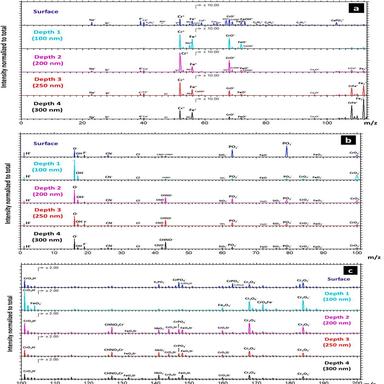
ToF-SIMS positive ion mass spectra (a) negative ion mass spectra at the different depths between b) 0 to 100 m/z and c) 100 to 200 m/z